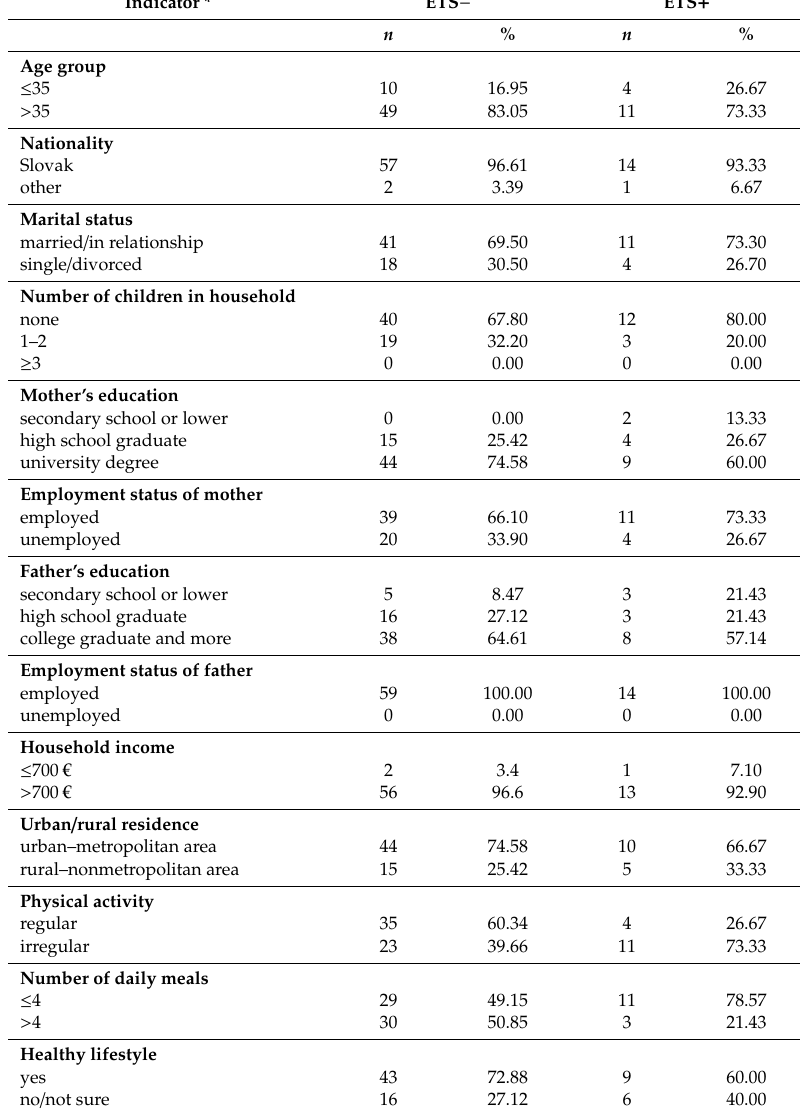
Table 2. Relation between demographic factors and mother’s exposure to tobacco smoke (cotinine objectified—0.06–2 mg / mol creatinine) n = 80.